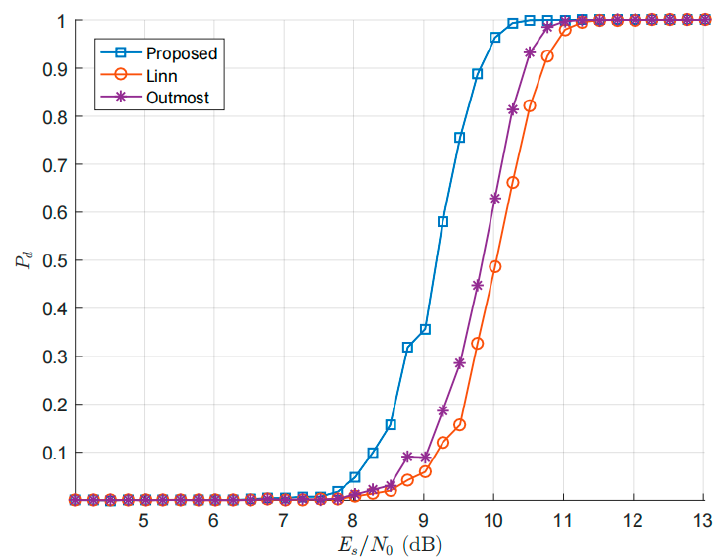
Figure 10. Lock detection probability of 16APSK.